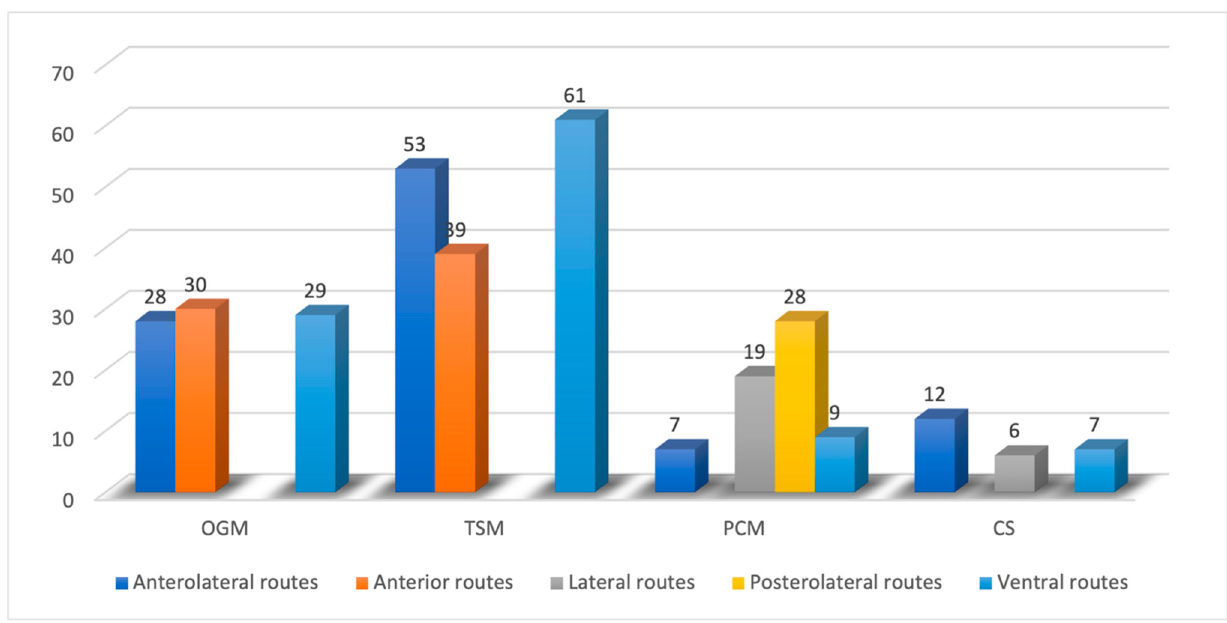
Figure 6. Distribution of employed routes per type of tumor.